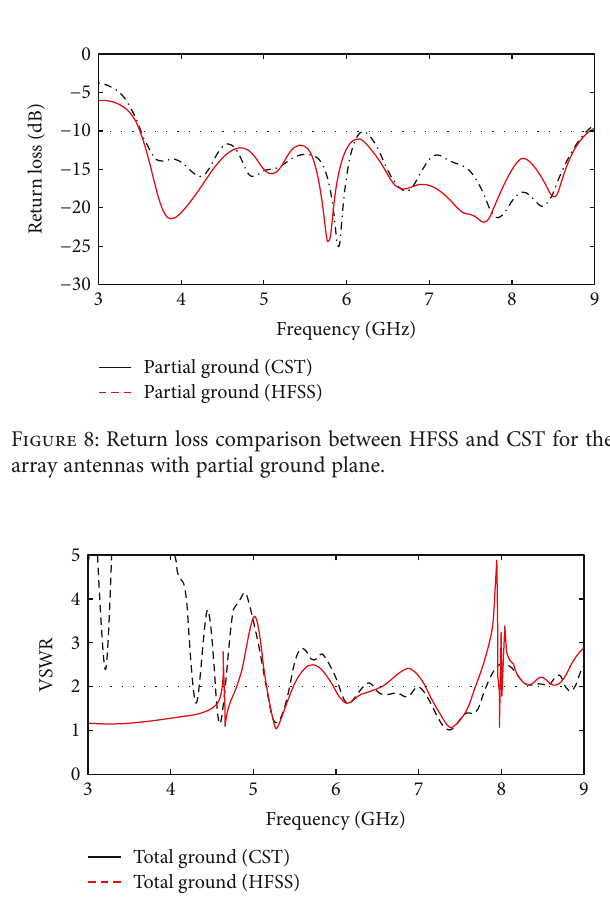
Figure 9: VSWR comparison between HFSS and CST for the array antennas with total ground plane.